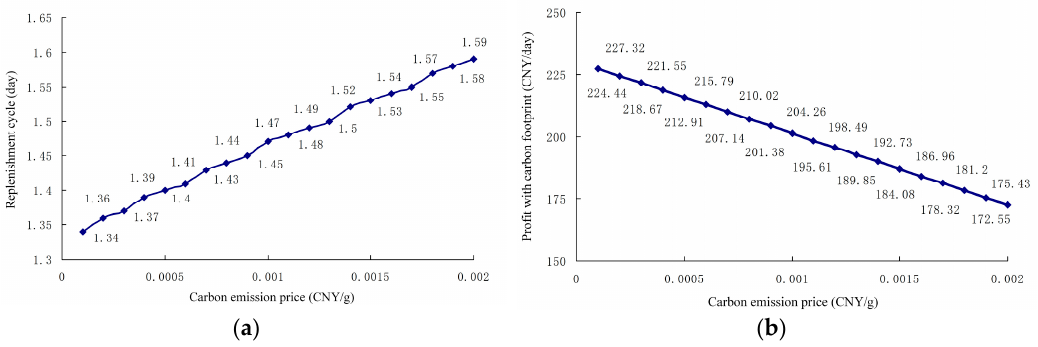
Figure 5. Influence of the carbon emission price: ( a ) the curve of the replenishment cycle; and ( b ) the curve of the profit with carbon footprint constraint.